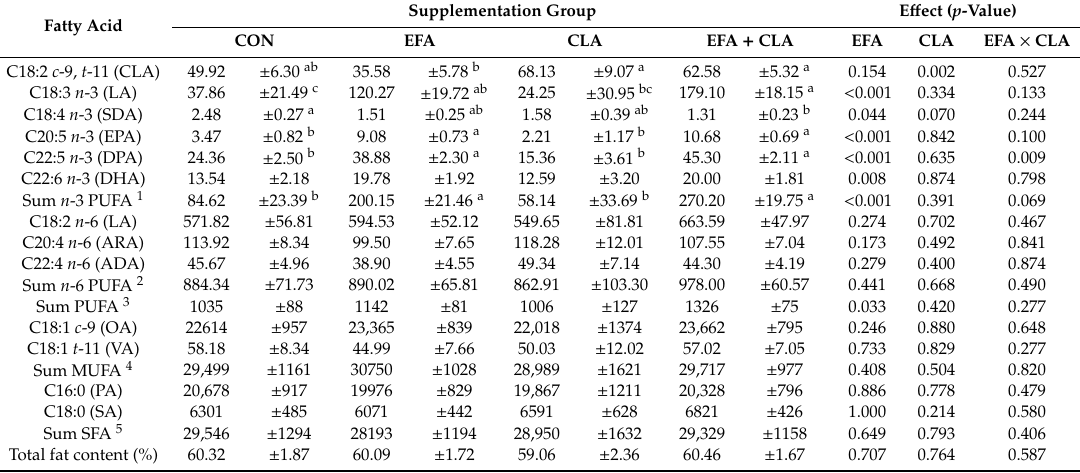
Table 3. Fatty acid concentration (mg / 100 g tissue) in kidney fat of calves of four maternal supplementation groups: Control group (CON, n = 8), essential fatty acids (EFA, n = 9), conjugated linoleic acids (CLA, n = 8), EFA + CLA (n = 11). Data are given as LSM ± SE LSM . Results for all measured fatty acids are listed in Supplementary Table